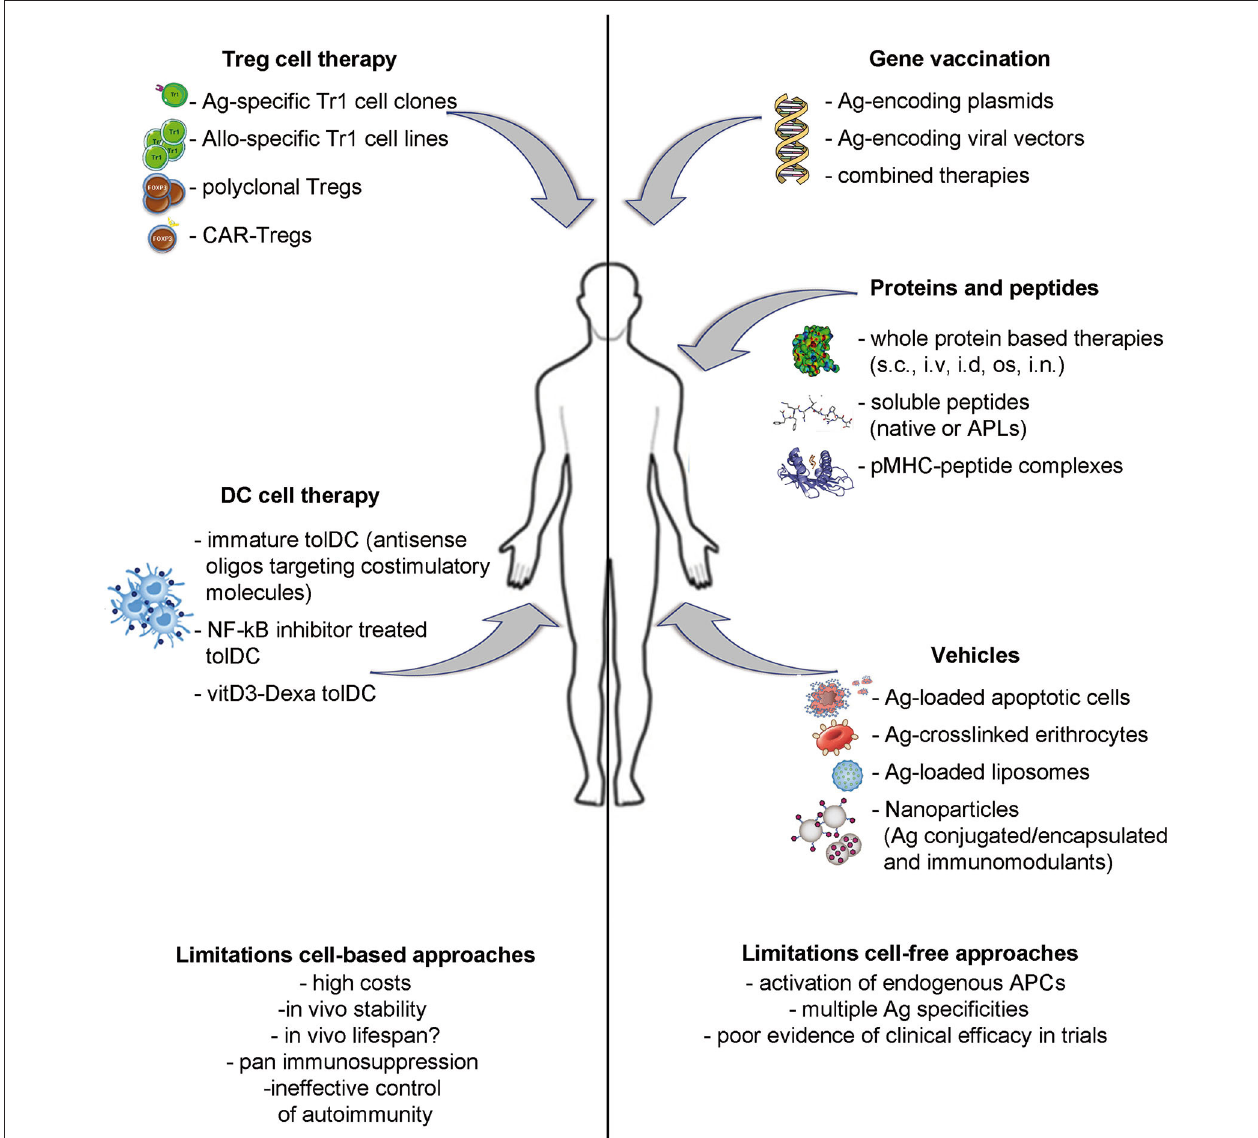
FIGURE 1 | Strategies to induce Ag-specific tolerance in T cell mediated diseases. Approaches under development include: inverse vaccination with autoantigen- encoding DNA or viral vectors; in vivo administration of whole Ags, unmodified peptides or altered peptide ligads (APLs); autoantigen-loaded vehicles; transfer of polyclonal or Ag-specific Tregs or of tolerogenic DC loaded with disease-relevant